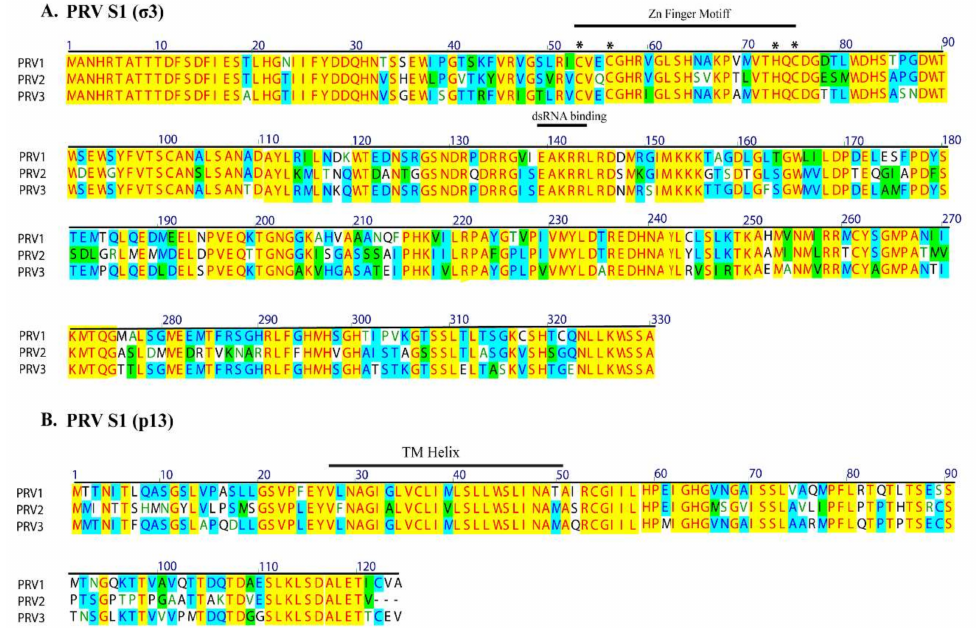
Figure 3. Alignment of deduced amino acid sequence of S1 segment of PRV-1, PRV-2, and PRV-3. The σ 3 and p13 proteins are encoded in overlapping reading frames. The conserved transmembrane (TM) helix of p13 are encoded by the same region that encodes the conserved Zn finger motifs of σ 3 (motifs labeled with *). Amino acid residues are numbered above. Identical sequence regions in all three PRVs are indicated by yellow background, identical amino acids shared by only two PRVs are in blue, and similar amino acids are shown with green background color.